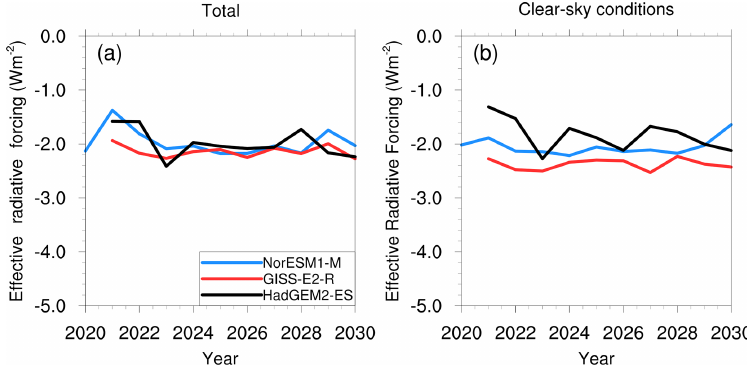
Figure 3. Global-mean TOA effective radiative forcing of the injected particles in total (a) and in clear-sky conditions (b) . The ERF for each model was determined from 10-year simulations with fixed SST with and without sea salt